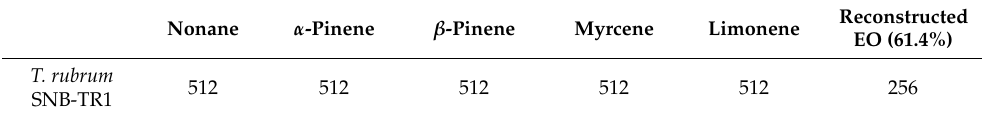
Table 3. Antifungal activity (MIC in µ g/mL) of the major constituents of Hypericum scabrum EO and a reconstructed EO from the major constituents on Trichophyton rubrum .